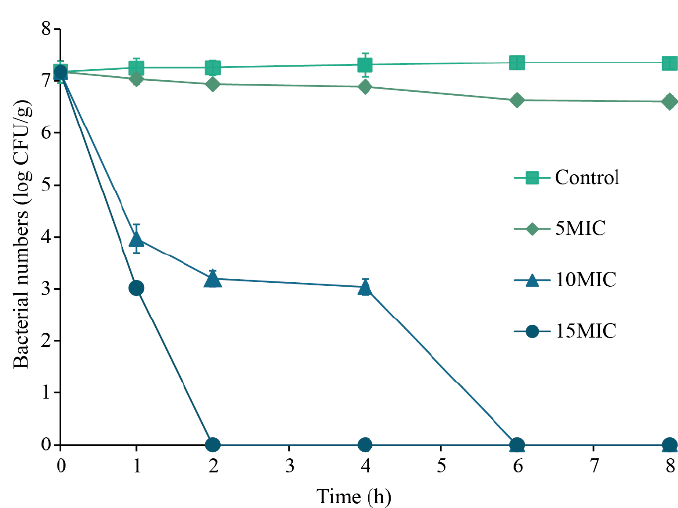
Figure 5. Inactivation effect of eugenol on Sh. flexneri in minced pork.